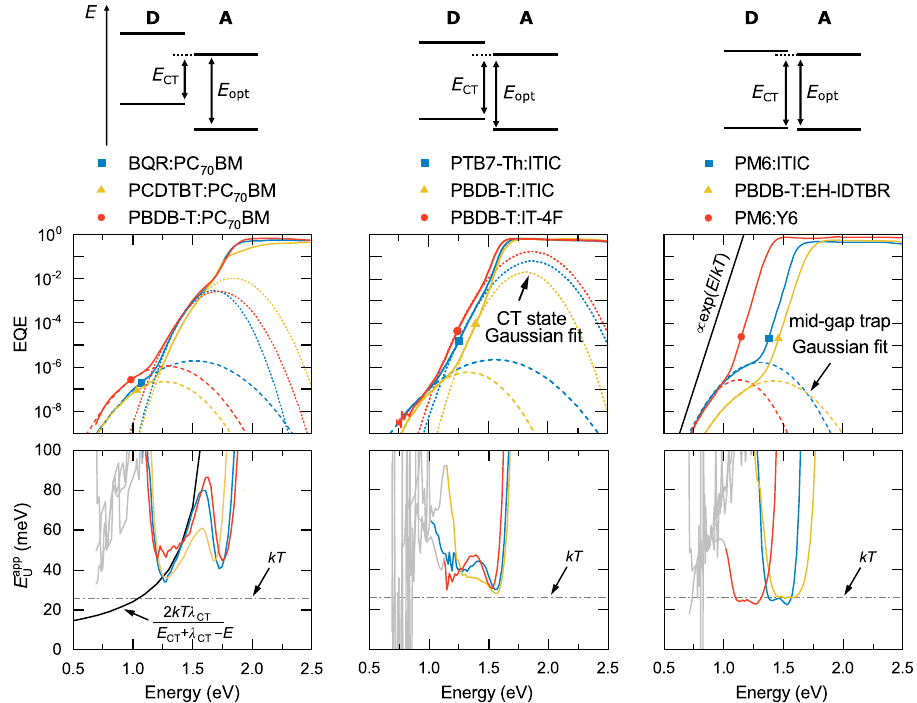
Fig. 1 EQE and E app for organic D:A blends with different energetic offsets between E CT and E opt . Schematic illustration of the energetic offset U ð E (cid:2) E Þ decreasing from left to right. Gaussian fi ts in the spectral range of CT state and trap state absorption are performed where possible. For low opt CT offset blends PM6:Y6, PM6:ITIC and PBDB-T:EH-IDTBR, the EQE tail has the form e E = kT , and E app by the absorption of the acceptor. For large offset material systems, such as BQR:PC 70 BM, PBDB-T:PC 70 BM and PCDTBT:PC 70 BM, E app 2 kT λ CT = ð E CT þ λ CT (cid:2) E Þ dependence in the spectral range of CT